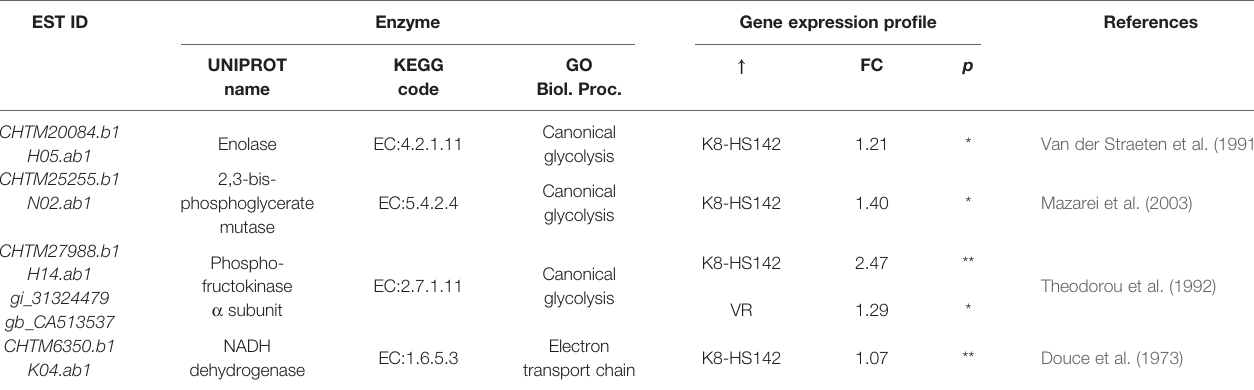
TABLE 3 | Differentially expressed (DE)/expressed sequence tags (ESTs) between clones at T 0 taking a role in the carbohydrate metabolism. EST